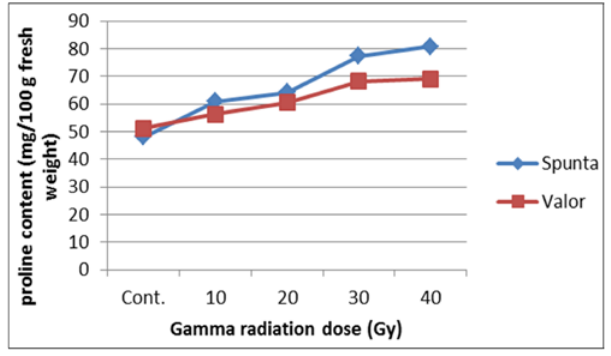
Fig. 2. Gamma radiation impact on potato shoot length cvs. ‘Spunta’ and ‘Valor’